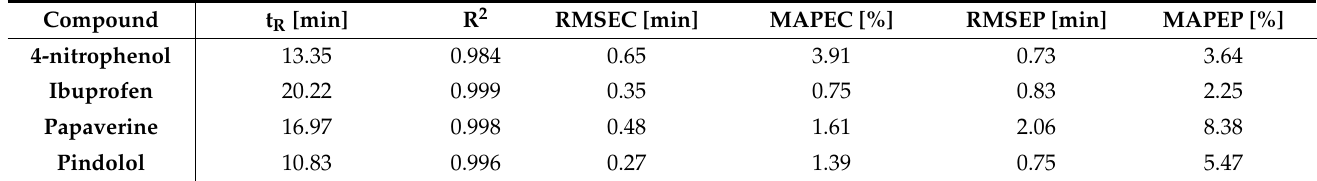
Table 1. Individual and global performance of models in calibration. tR is the retention time at pH 5.0 with a gradient time of 20 min.